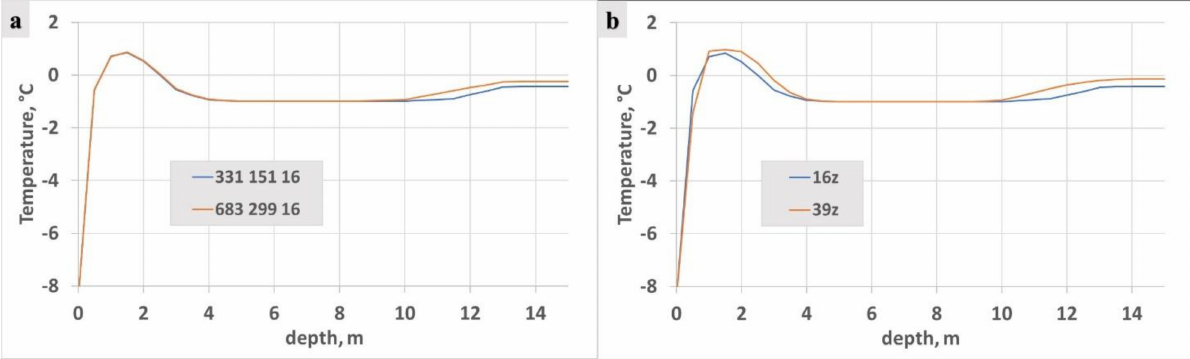
Figure 14. Comparison of temperature profiles at a depth of up to 15 m, calculated on a grid of 331 × 154 × 16 and a two-times finer grid { x , y } on a grid of 662 × 154 × 16 ( a ) and on a grid of 331 × 154 × 39 ( b